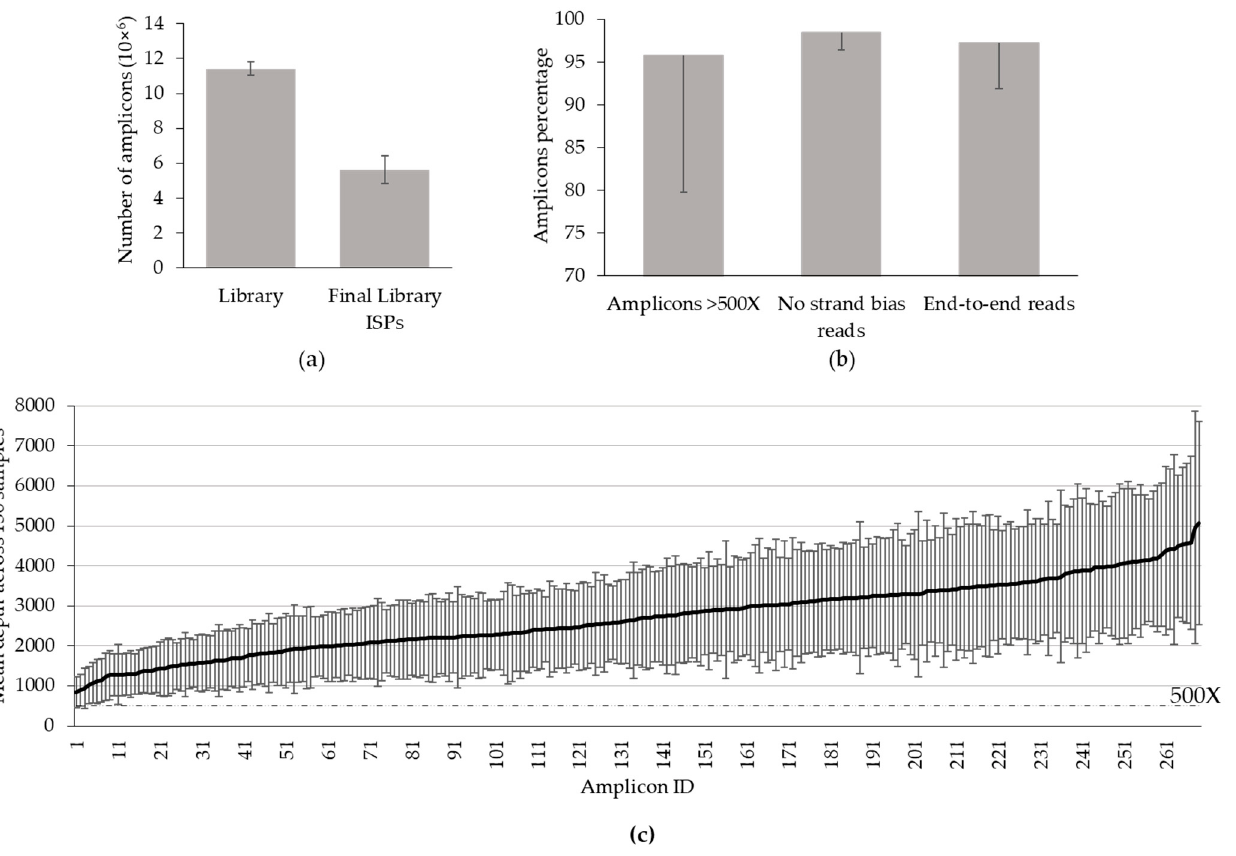
Figure 1. Quality metrics of the OFA DNA panel. ( a ) Number of amplicons per 520 chip for DNA sequencing. Library: live wells with library template sequence; Final library ISPs (Ion Sphere™ Particle): sequence available for analysis after filtering (following removal of polyclonal ISPs, low quality sequences, and adapter dimers) ( n = 73 chips). ( b ) Percentage of amplicons. Amplicon >500X: percentage of amplicons with at least 500X reads; No strand bias reads: percentage of amplicons that did not show a bias. An individual amplicon has read bias if the percentage of forward or re- verse reads to total reads is greater than 70%; End-to-end reads: the percentage of on target reads that fully covered their assigned sequence from end-to-end ( n = 400 samples). ( c ) Mean amplicon coverage across patient samples ( n = 136 samples). The amplicon IDs are listed in Appendix B. Errors bars represent the standard deviation.